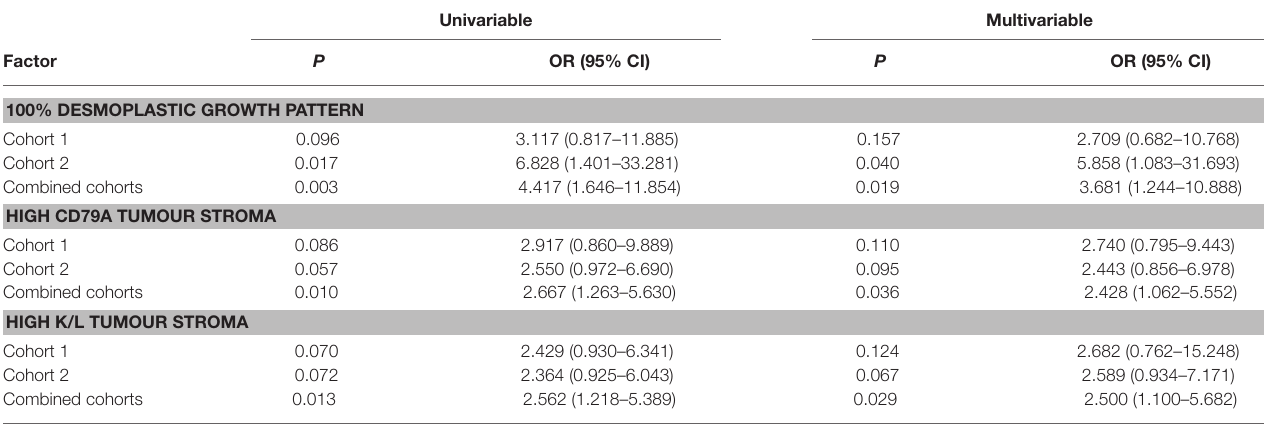
TABLE 3 | Multivariable analysis to predict survival. Univariable Multivariable